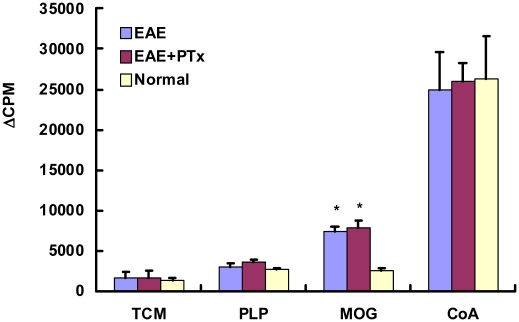
T cell proliferation responses to the Ag (MOG35–55 peptide) were assessed in triplicate wells for each experiment.It showed a significant difference in PTx+ EAE and EAE versus control (* p<0.01). But there was no difference between PTx+ EAE and EAE mice. Results are expressed as Δcpm (mean cpm stimulated cultures – mean cpm unstimulated cultures). N = 6/group.